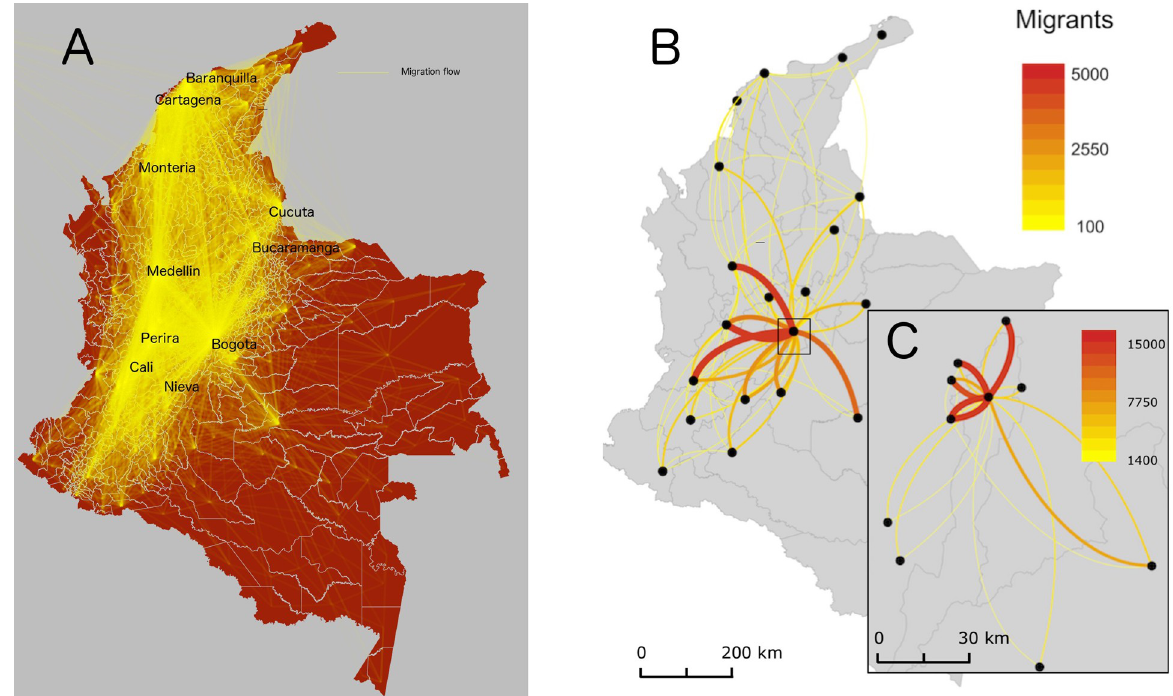
Fig 7. Estimated migration flows (A) between each pair of municipalities with lines going in both directions, (B) between municipalities that have the 20 highest migration flows and have distances of more than 100 km from each other, and (C) between municipalities that have the 10 highest migration flows and are within 100 km from Bogota. Centroid points are weighted by the spatial distribution of population in each municipality.